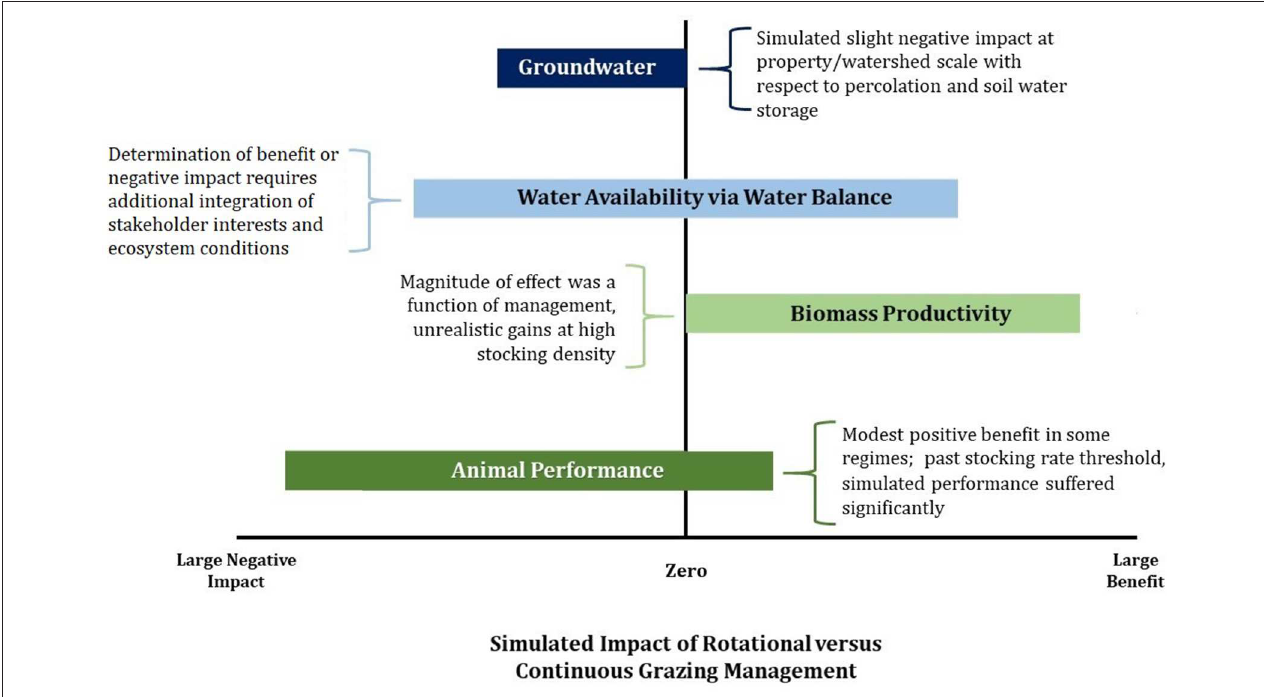
FIGURE 7 | Summary of findings for four selected benefits, including qualitative assessment of direction of effect (e.g., positive, zero, or negative) of rotational grazing based on the simulation